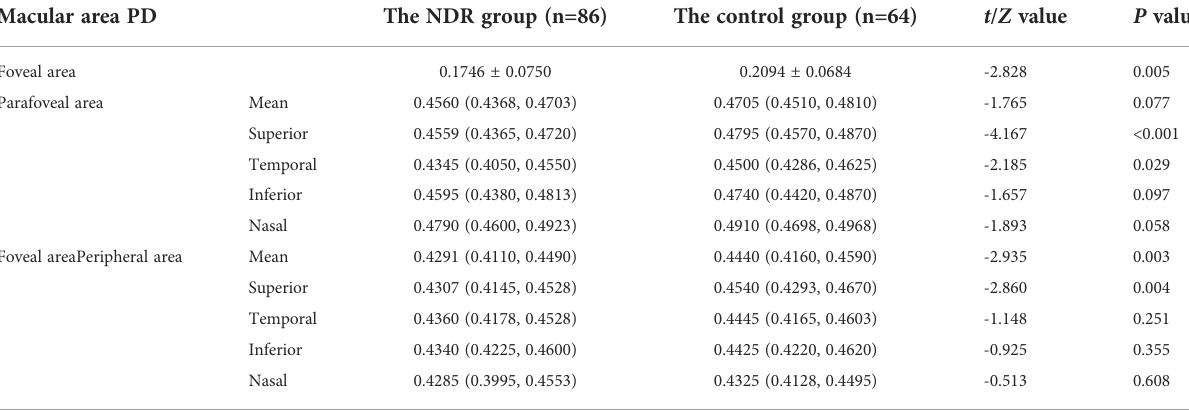
TABLE 2 PD results in the macular area of the affected eyes of NDR patients and tested eyes of the control group. Macular area